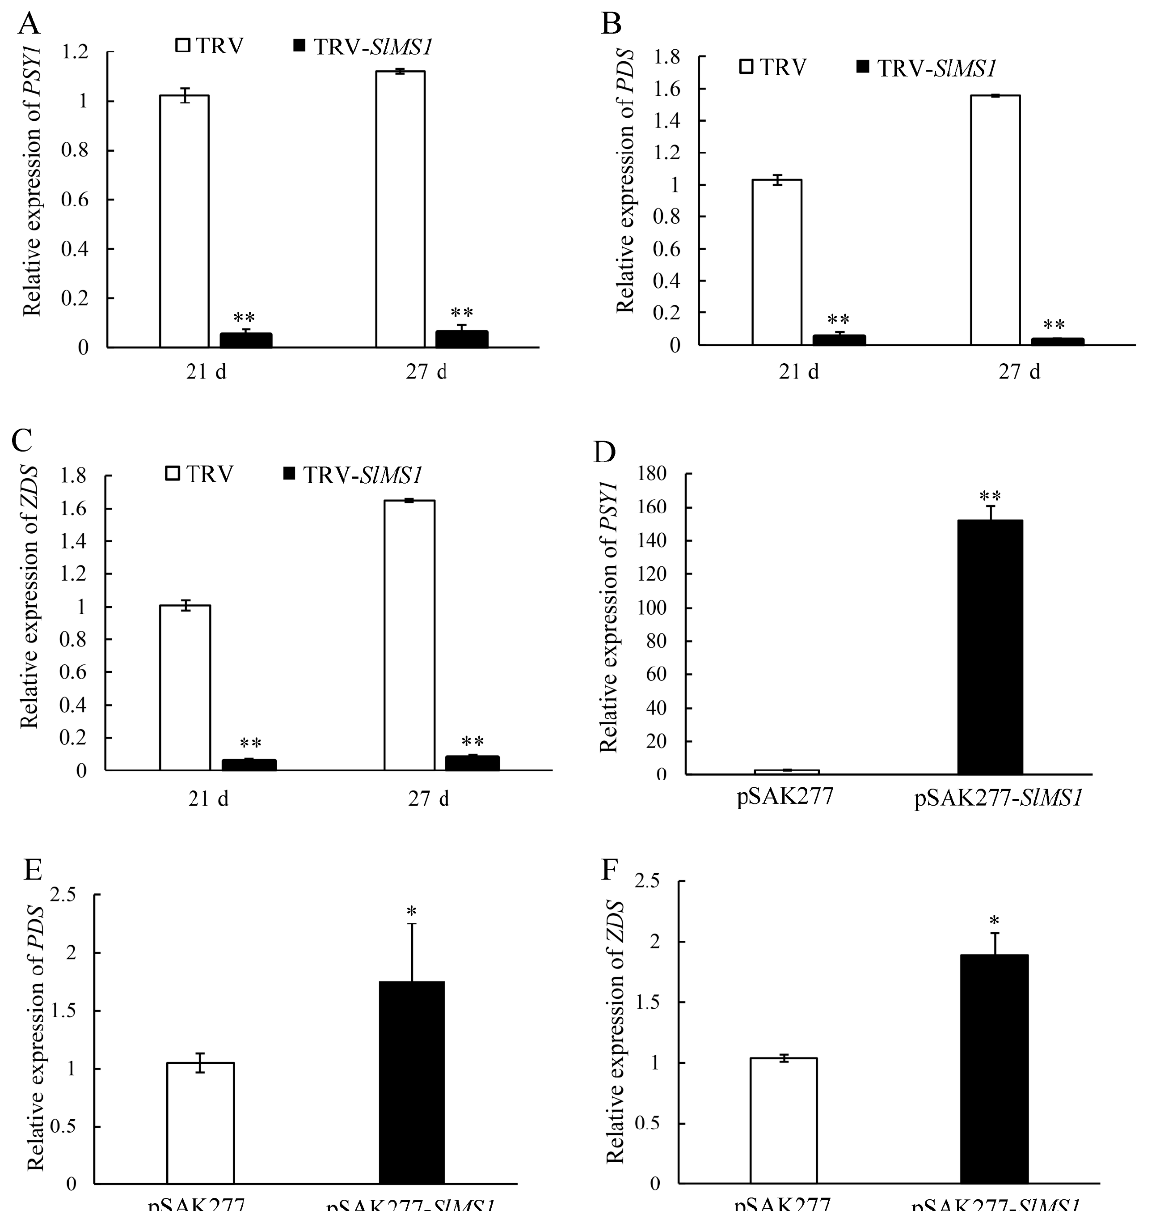
Figure 5. Effect of transient silencing and transient overexpression of SlMS1 on gene expression of lycopene biosynthesis related genes PSY1, PDS and ZDS in tomato fruit. ( A – C ) Relative gene expression of PSY1 ( A ), PDS ( B ) and ZDS ( C ) in control (TRV) and SlMS1 -silenced fruit (TRV- SlMS1 ) at 21 and 27 days post inoculation. ( D – F ) Relative gene expression of PSY1 ( D ), PDS ( E ) and ZDS ( F ) in control (pSAK277) and SlMS1 -overexpressed (pSAK277- SlMS1 ) fruit at 10 days post inoculation. The symbols * and ** stand for p < 0.05 and p < 0.01, as determined by Student’s t -test, respectively.